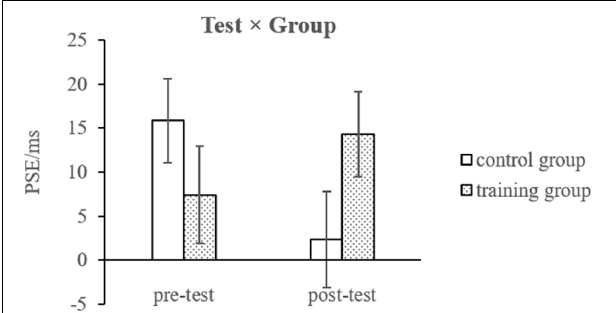
FIGURE 4 | The interaction between test sessions and groups for points of subjective equality (PSEs). The error bars represent standard errors of the